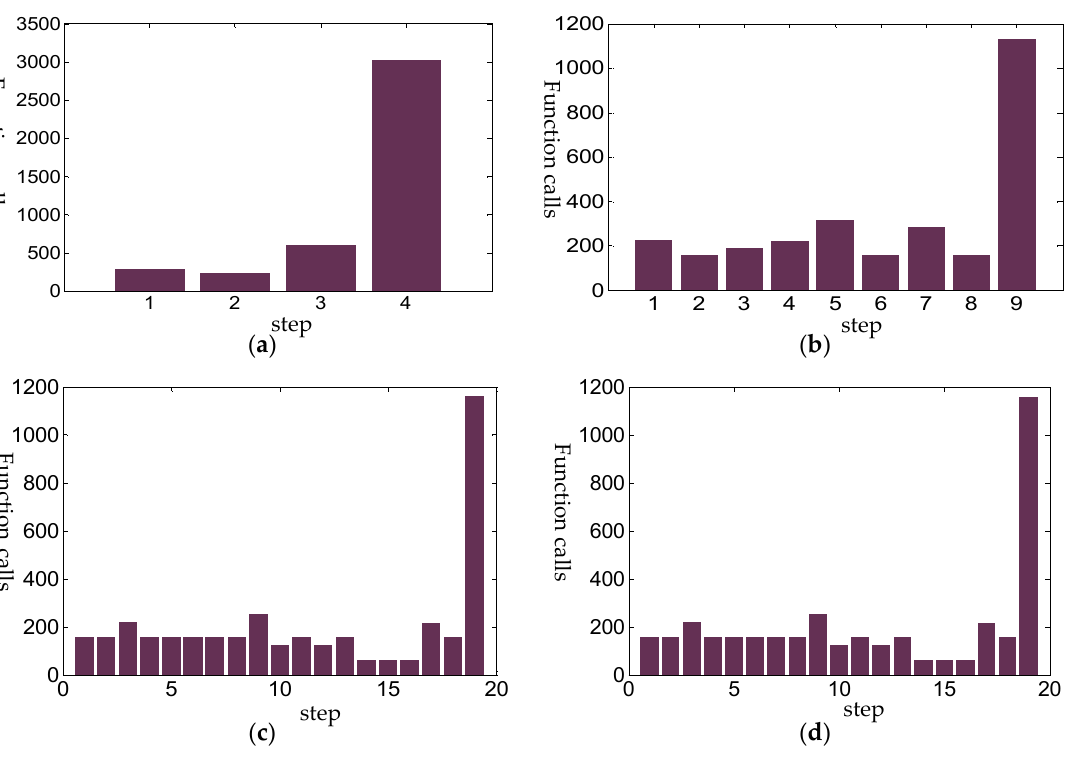
Figure 8. The distribution of the function call numbers for the first N − 1 sampling steps. ( a ) Sampling steps of 5; ( b ) Sampling steps of 10; ( c ) Sampling steps of 20; ( d ) Sampling steps of 50.